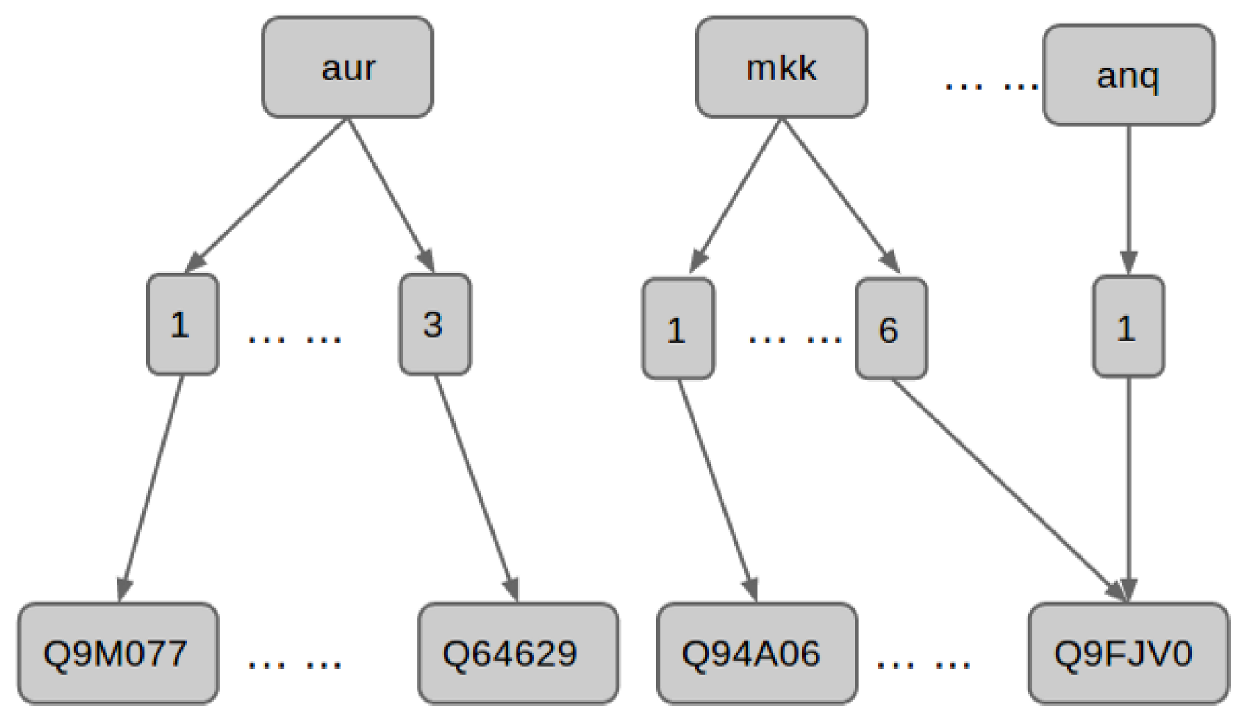
Fig 3. Pivot based plant gene dictionary